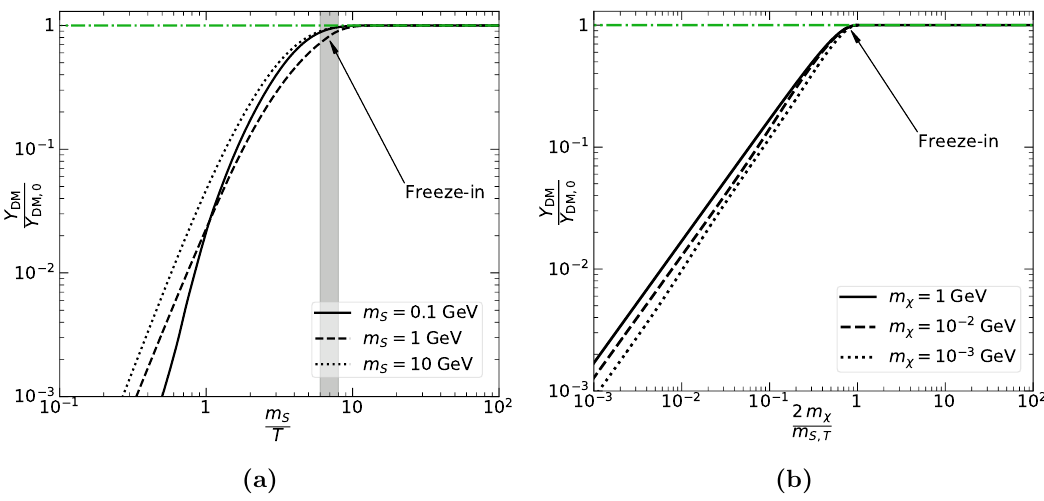
Figure 2. Typical evolution of Y DM =Y DM during the production of DM. (a) The evolution as a ; 0 function of x m S =T for m S = 0 : 1 ; 1 ; 10 GeV, and m (cid:31) = 0 (i.e., standard freeze-in ). The gray (cid:17) area denotes where the freeze-in occurs. (b) The evolution as a function of z m (cid:31) = 10 (cid:0) 3 ; 10 (cid:0) 2 ; 1 GeV, and m S = 0 (i.e., forbidden freeze-in). In both (cid:12)gures, green lines